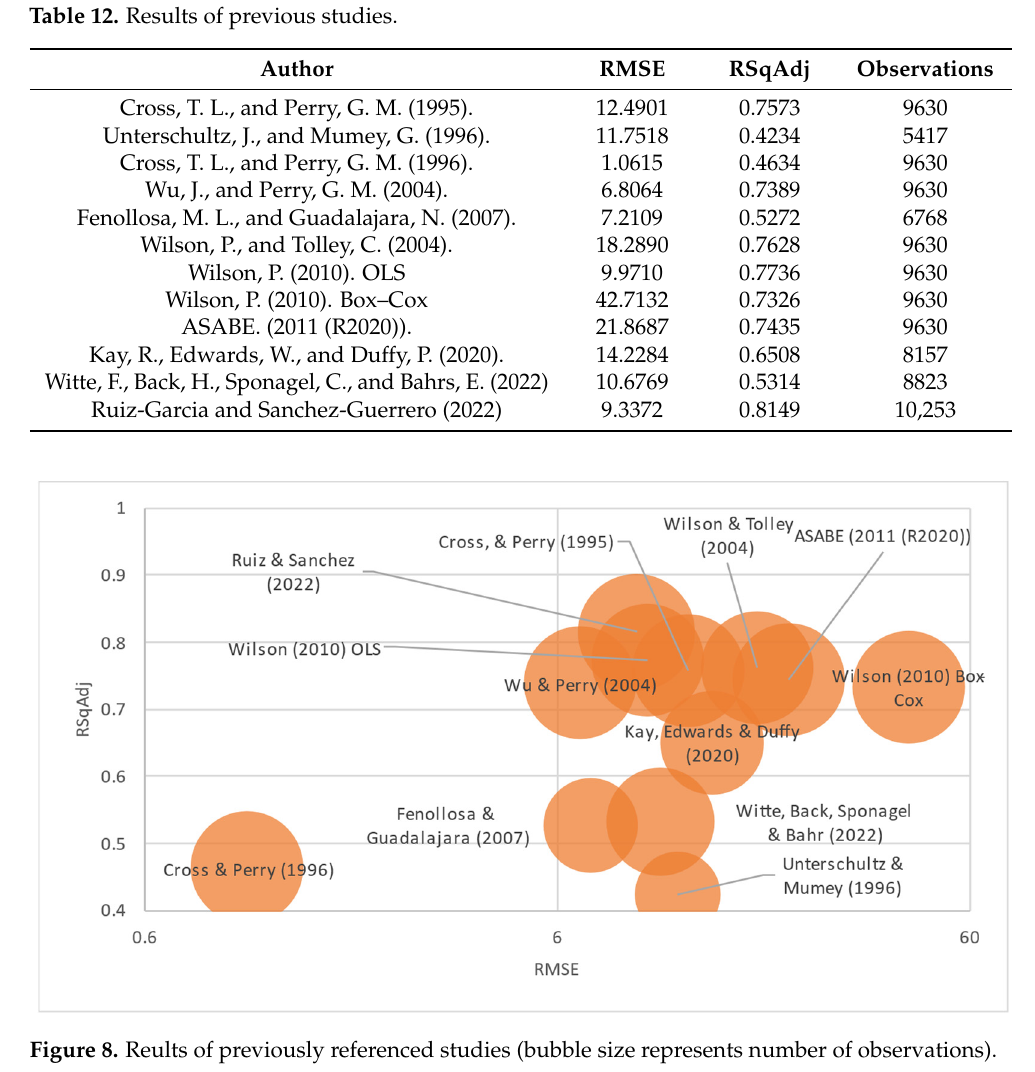
Figure 9. Summary of all regressions considered in this study (proposed power regression in blue,previous studies referenced in orange, fitted multiple variables and validation models in yel- low, and fitted tractor family models in gray) (bubble size represents number of observations). Compared to the previous studies referenced, the proposed power regression model provides better RMSE and RSqAdj values as it considers not only the brand and very sim- ilar power and tractor size (wheelbase and mass) but also very similar specification levels (e.g, transmissions and user interfaces), relating these factors to an equivalent new model that provides a precise price reference, including inflation and production costs. These variations yield a better foundation for more robust results Compared to more advanced fitting models that require specific software, the pro- posed power regression model provides better RMSE and RSqAdj values and a simpler methodology that is applicable using a more mainstream software.